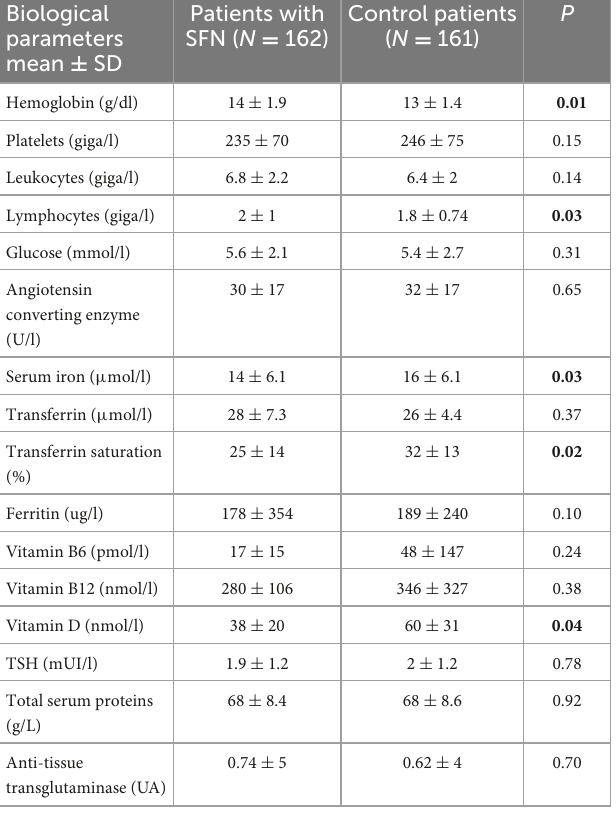
TABLE 3 Biological parameters recorded at the time of skin biopsy as part of the explorations of conditions associated with possible SFN. Biological Patients with Control patients parameters SFN ( N = 162) ( N = 161) mean ± SD